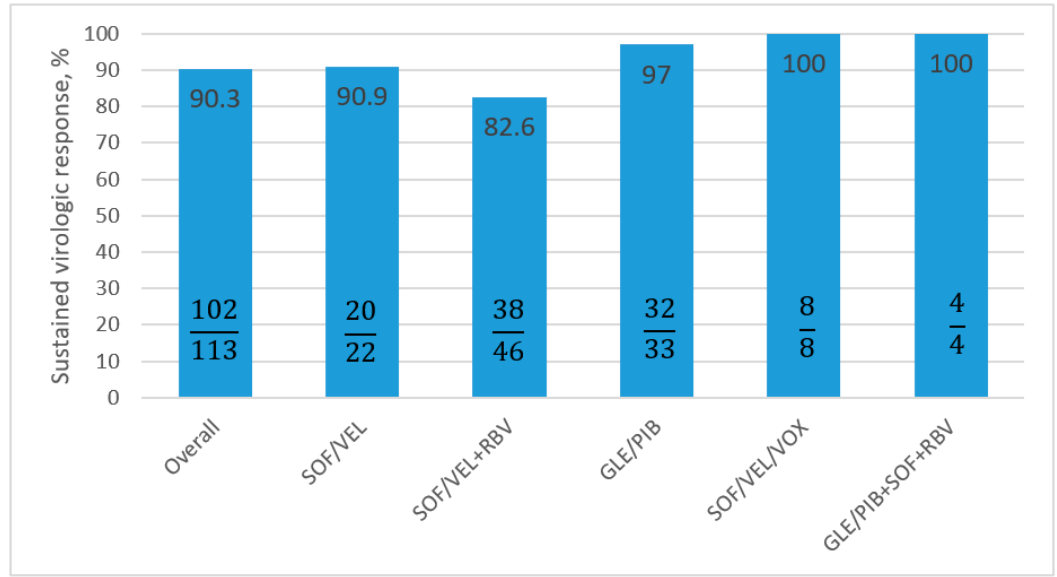
Figure 1. Treatment effectiveness according to regimen, calculated as PP analysis. PP: per protocol; SOF: Sofosbuvir; VEL: Velpatasvir; RBV: Ribavirin; GLE: Glecaprevir; PIB: Pibrentasvir; VOX: Voxi- laprevir.